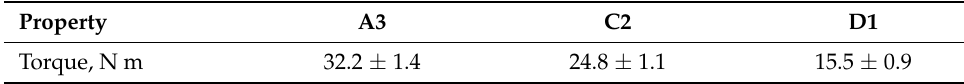
Table 9. Torque values at 5 min for the blends A3, C2, D1.